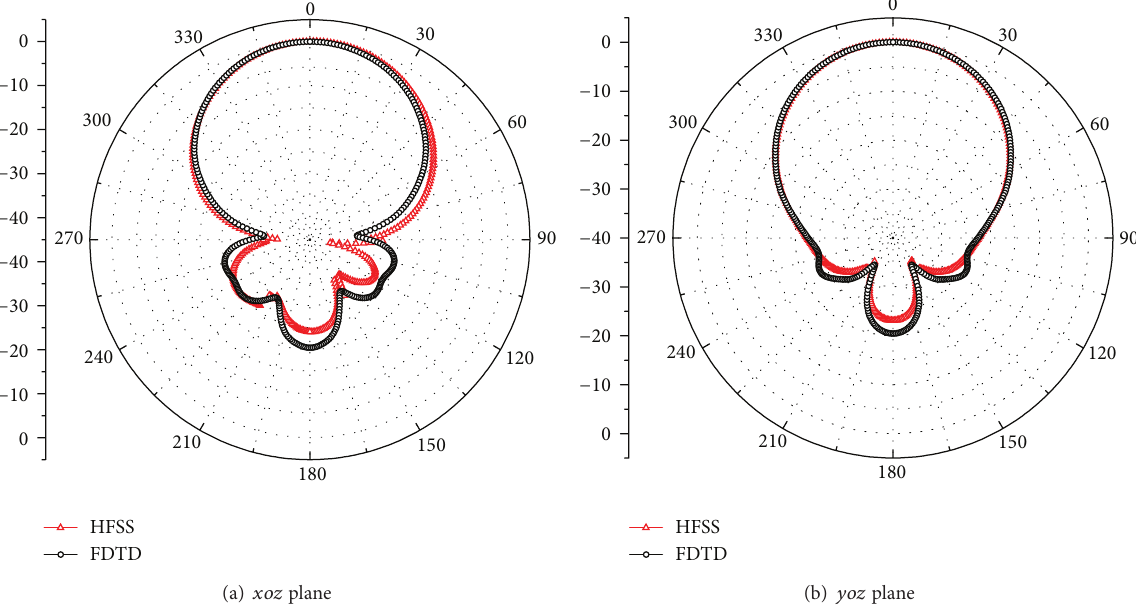
Figure 2: The radiation patterns of the 2 × 2 microstrip antenna array.